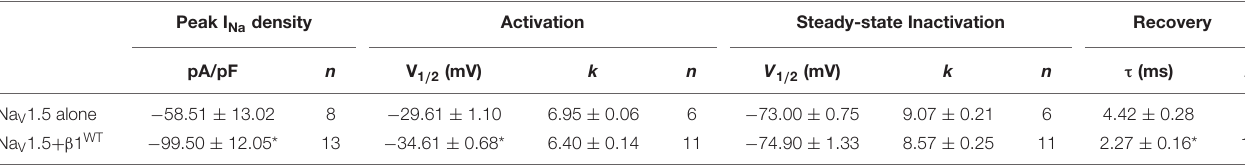
TABLE 1 | Biophysical parameters of HEK cells expressing Na V 1.5 alone or together with β 1 WT . Peak I Na density Activation Steady-state Inactivation Recovery